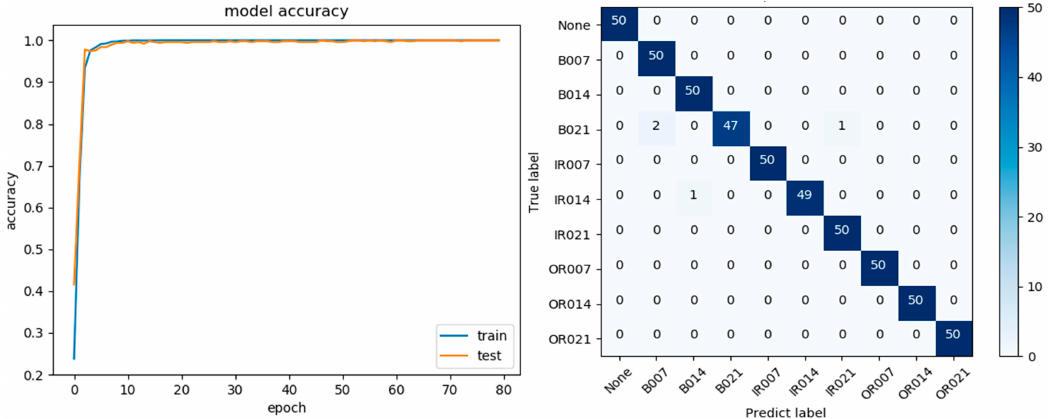
Figure 11. Diagram of the 2d-DCNN model ( a ) the training process and ( b ) confusion matrix;